Question: Write a caption explaining this figure to a reader.
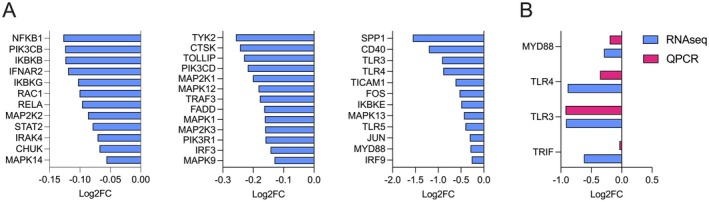
Answer: TLR pathway genes whole transcriptome sequence and qPCR. (A) Log 2 fold change gene expression levels of main genes in the TLR signalling pathway. (B) Gene expression confirmation by qPCR vs. whole transcriptome sequence. MYD88, MYD88 innate immune signal transduction adaptor; TLR3, toll‐like receptor 3; TLR4, toll‐like receptor 4; TRIF or TICAM1, TIR domain containing adaptor molecule 1.